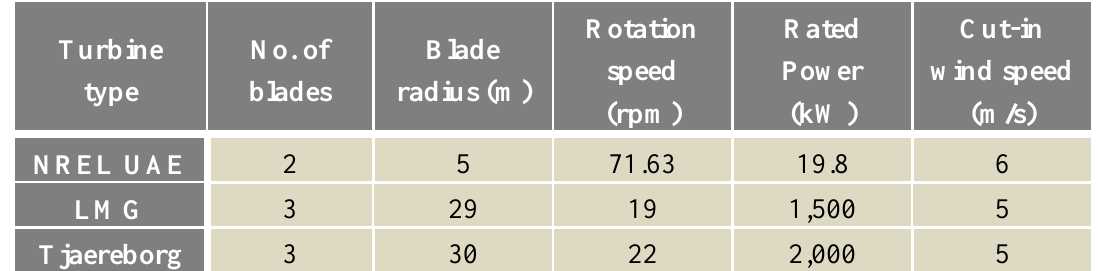
Table 1. Summary of turbine properties for model